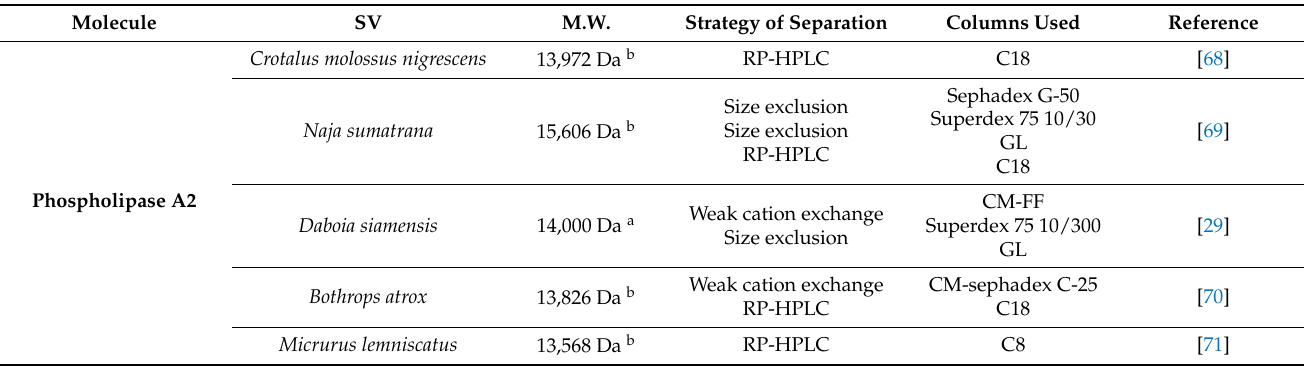
Table 2. Different separation strategies used most recently to isolate the most abundant SV protein families. Da: Dalton, ND: Not Determined, a MW determined by SDS-PAGE, b MW determined by